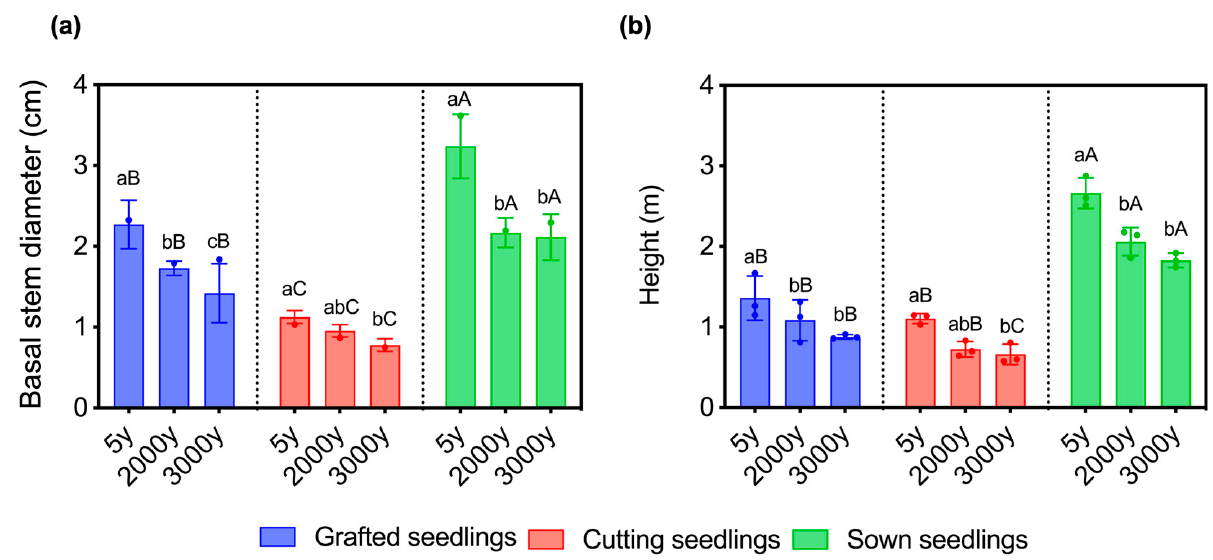
Figure 2. Variation in ( a ) basal stem diameters and ( b ) heights of seedlings of P. orientalis propagated from donors at di ff erent ages (5-, 2000-, and 3000-year-old) in di ff erent methods (seed sowing, cut- ting, and grafting), respectively. Le tt ers (a–c) on top of the error bars show the signi fi cance of dif- ferences between seedlings propagated from donors at di ff erent ages (5-, 2000-, and 3000-year-old); Le tt ers (A–C) on top of the error bars show the signi fi cance of di ff erences between seedlings prop- agated in di ff erent propagation methods (seed sowing, cu tt ing, and grafting). Values are the mean of three replicates of samples, and bars represent standard errors. Means with the di ff erent le tt ers are signi fi cantly di ff erent at p < 0.05 by Duncan’s multiple range test.